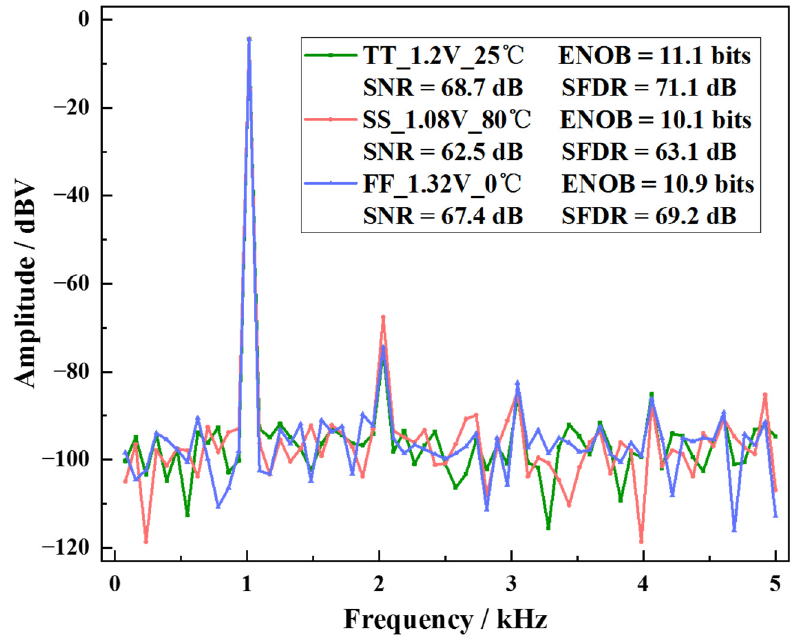
Figure 9. Under the condition of TT_1.2V_25 °C, the ENOB is 11.1 bits, SNR is 68.7 dB, and SFDR is 71.1 dB. The performance of ADC at TT_1.2V_25 °C is better than that of other processes, and at SS_1.08V_80 °C is the worst.